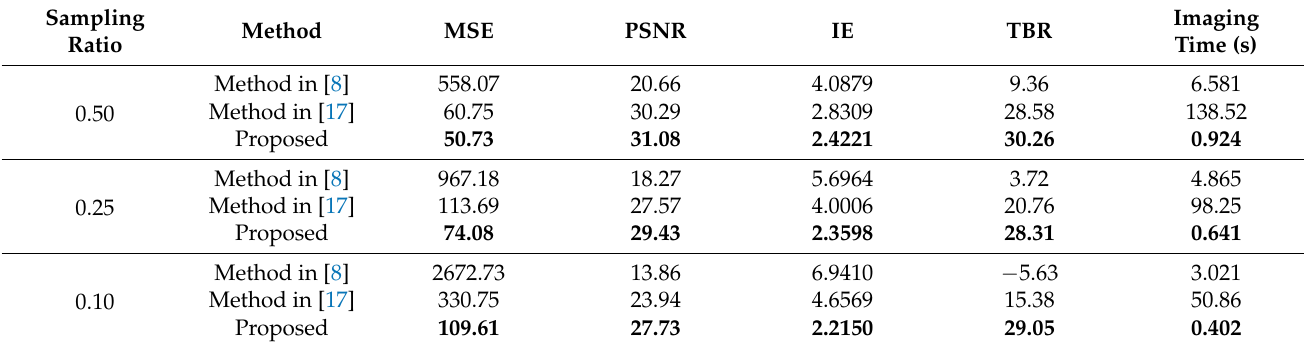
Table 1. Evaluation of different sampling ratios.